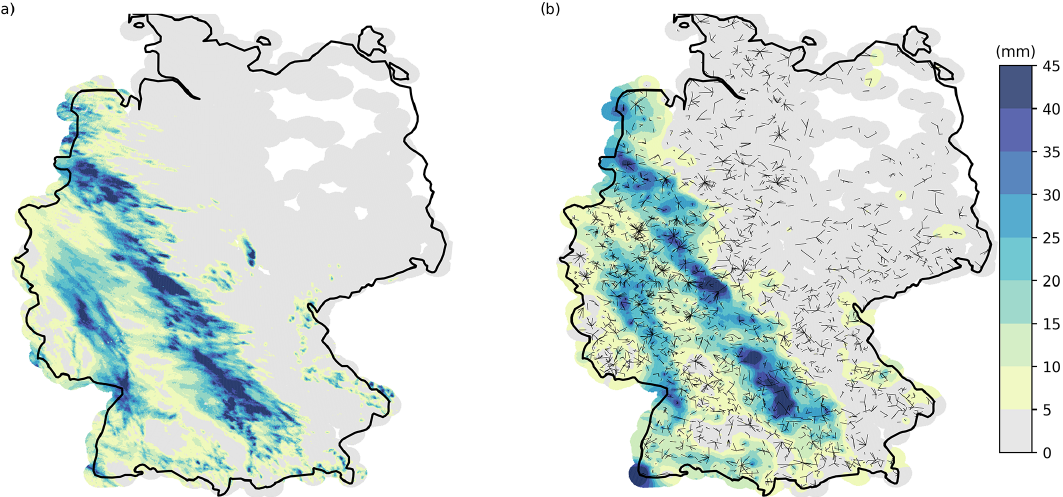
Figure 7. Accumulated rainfall for a 48h showcase from 12 to 14 May 2018 for (a) RADOLAN-RW and (b) CML-derived rainfall. CML- derived rainfall is interpolated using a simple inverse distance weighting interpolation. A coverage mask of 30km around CMLs is used. This showcase is visualized in a video supplement with an hourly resolution (Graf et al.,